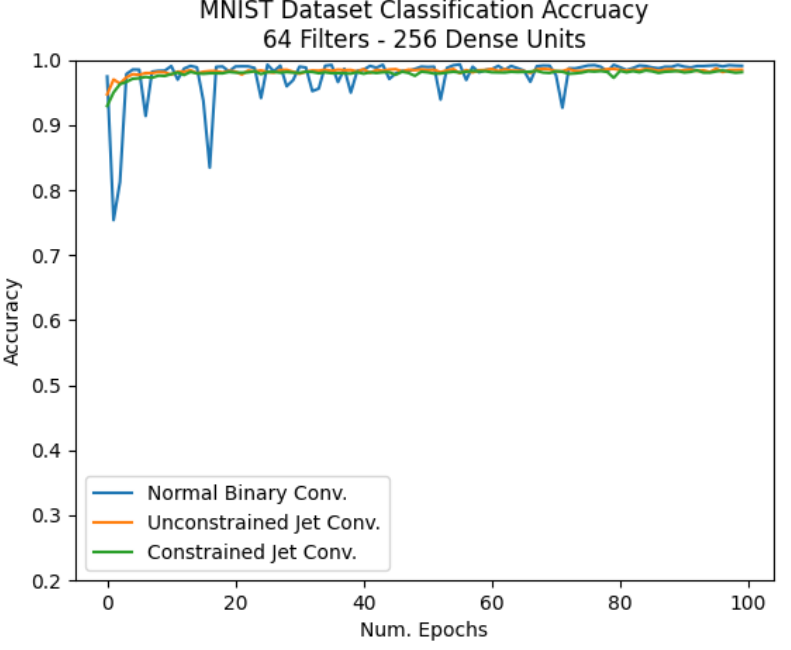
Figure 14. Classification accuracy on the MNIST dataset with 64 filters and 256 dense